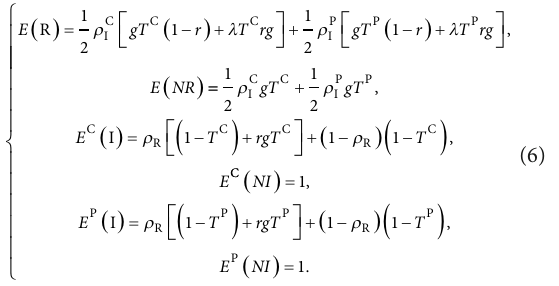
FIGURE 4 Experimental and predicted results of the global cooperation rate in tPDG. The solid lines represent the time evolution of the global cooperation rate in the iterated tPDG experiments and shaded areas represent standard error. The blue (red) lines represent OT (PL) group. The dotted lines represent the global cooperation rate at the stable fixed point of the replicator